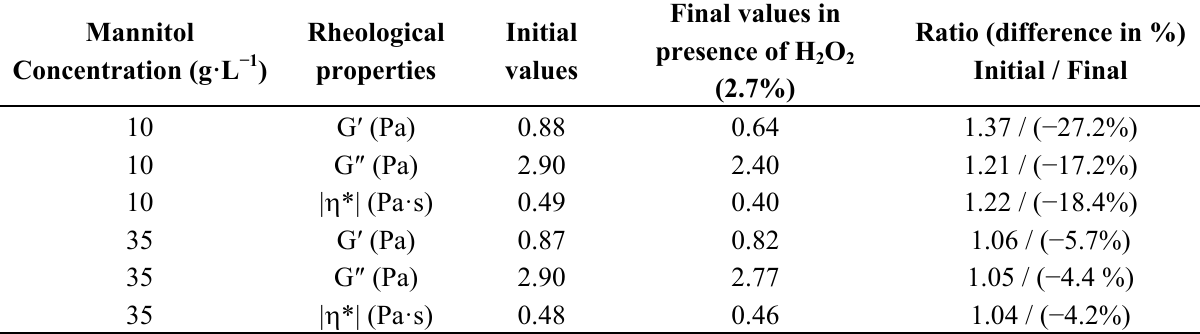
Table 2. Elastic modulus (G ′ ), viscous modulus (G ″ ) and complex viscosity (|  *|) of